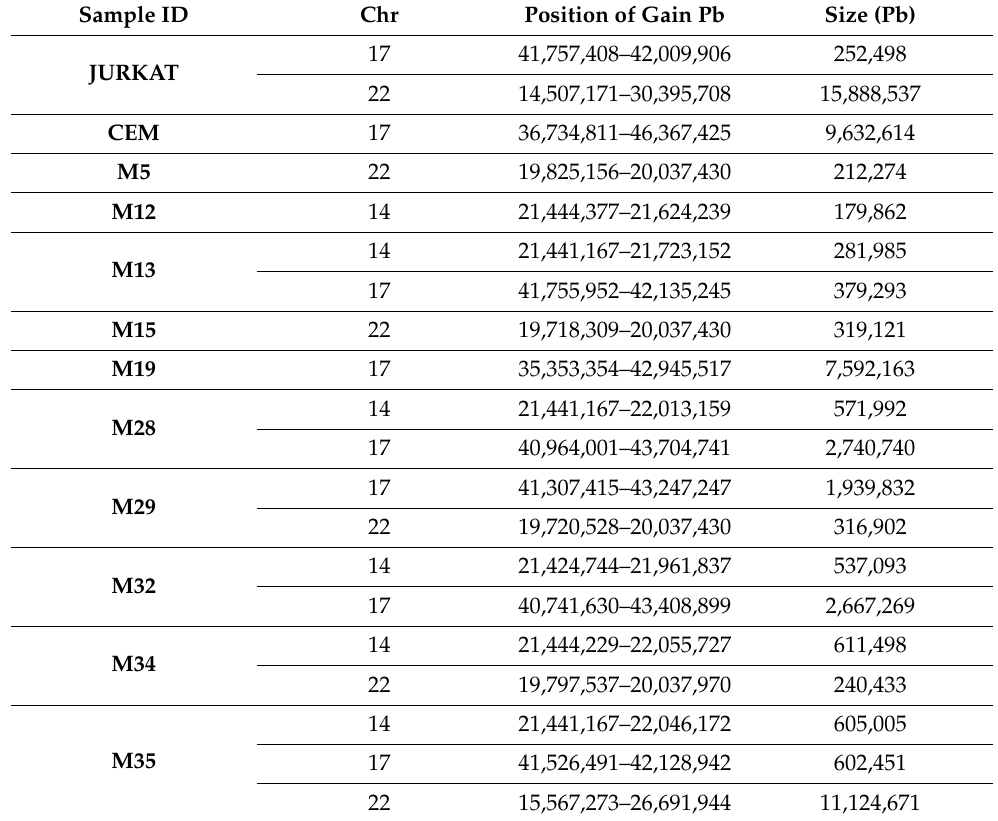
Table 3. Description of chromosomal gains found in each of the samples analyzed. Chr: chromosome; Pb: base